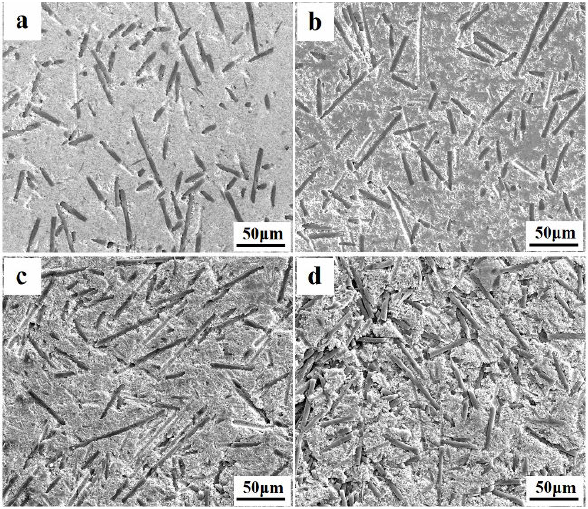
Fig. 2 SEM images of the polished surfaces of ZrB 2 –SiC–C f composites: (a) ZSC20, (b) ZSC30, (c) ZSC40, and (d) ZSC50, showing a uniform distribution of carbon fibers in the composites.